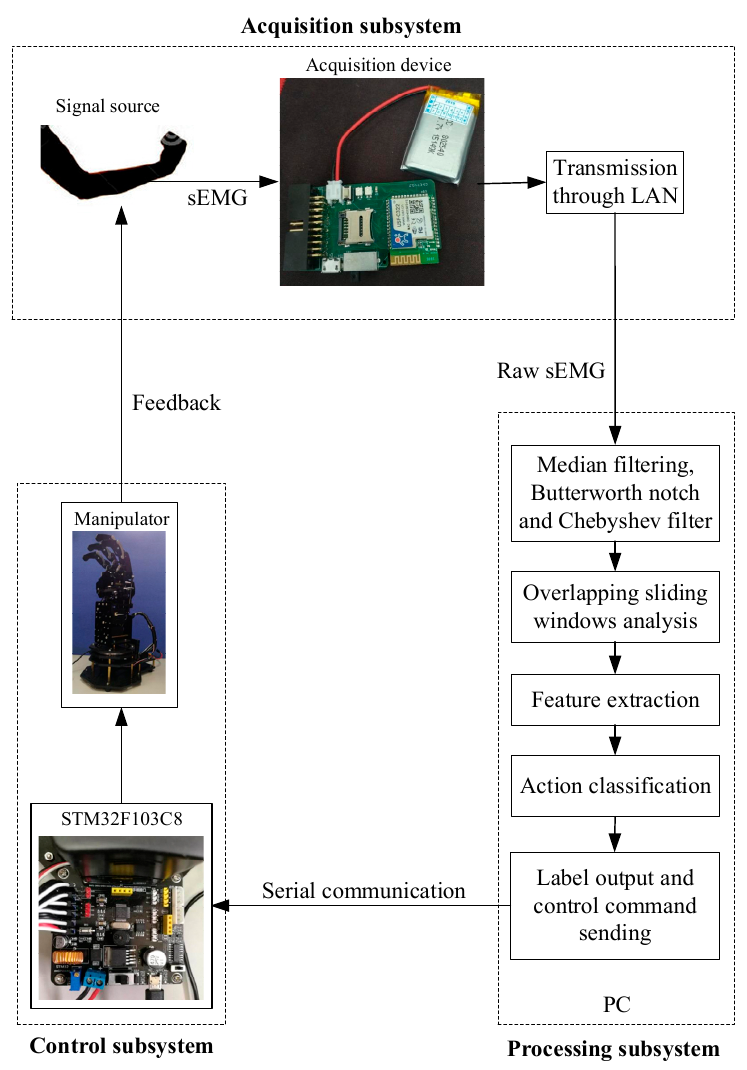
Figure 3. The composition of sEMG detection and action recognition system. The signal acquisition, processing, and manipulator control are based on a variety of hardware and software. Our self- developed acquisition device acquires 4-channel sEMG signals and transmits the data to a PC by LAN. Later noise removing, overlapping sliding windows dividing, feature extraction, and action classification are carried out on the PC. The classifier outputs the label and the control command is sent by a serial port to the manipulator. Subsequently, the manipulator does the action and follows the